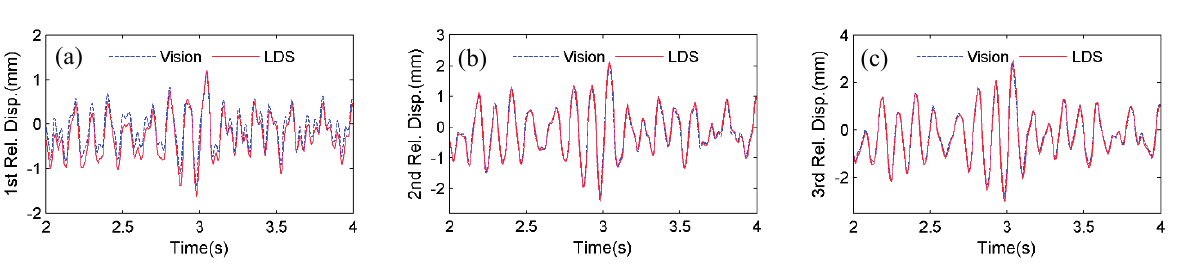
Figure 8. Comparisons of displacement relative to base floor between Vision (artificial target) and LDS: ( a ) 1st floor; ( b ) 2nd floor; ( c ) 3rd floor.